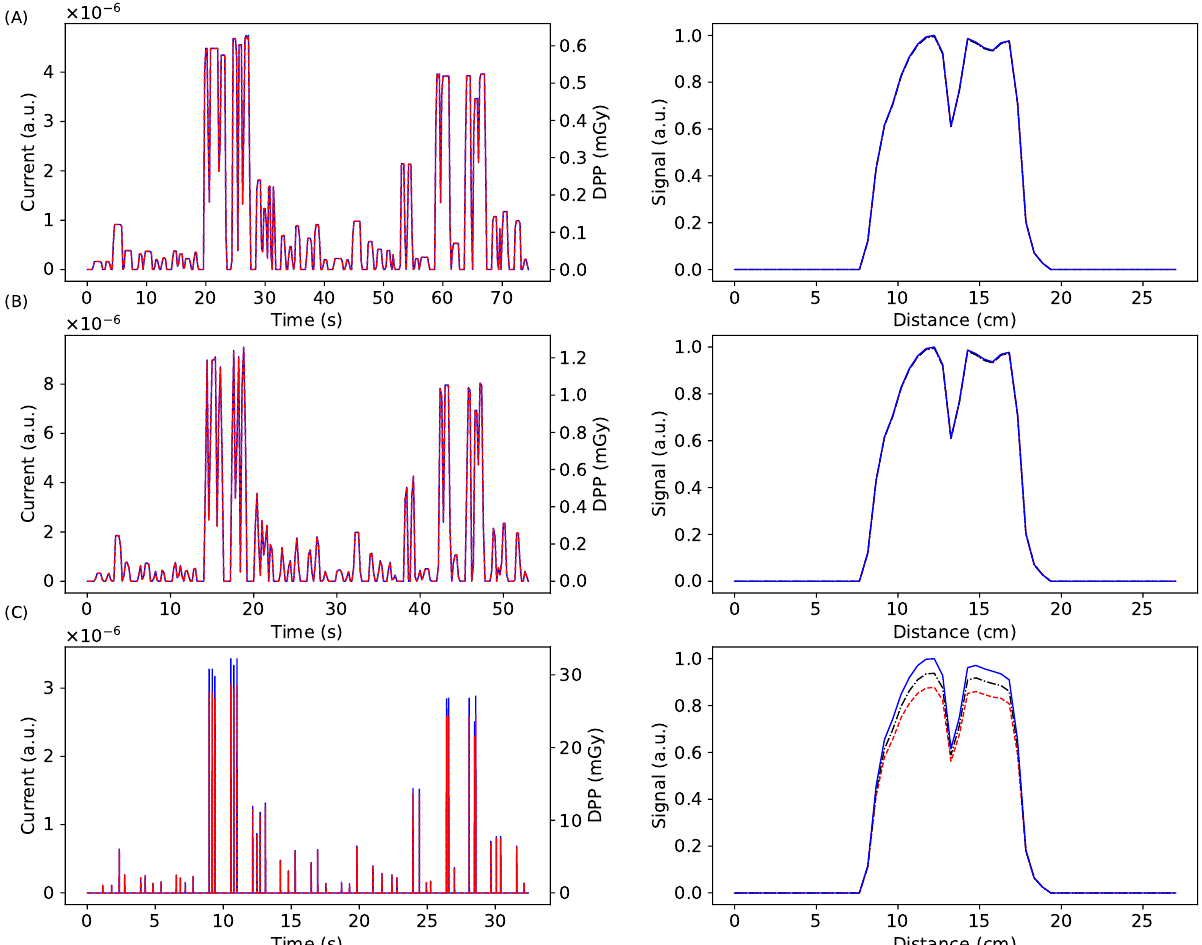
Figure 4. Effect of recombination and recombination correction in the verification of a dynamic radiotherapy clinical treatment with a PTW1500-like air-chamber. The dynamic dose rate corresponds to that of a lymph node tumor treatment, but scaled up to deliver a maximum dose per pulse of 1 ( A ), 2 ( B ) and 50 mGy ( C ). In the left panels we show for a particular pixel the raw readout current (red lines) and corrected readout current (blue lines) versus time. Notice that the dose per pulse in this pixel does not reach the maximum dose per pulse of the delivery. In the right panels we show a profile of the radiation field (the one shown in Figure 2), including generated charge (solid line), raw collected charge (dashed line), and corrected charge (dash-dot